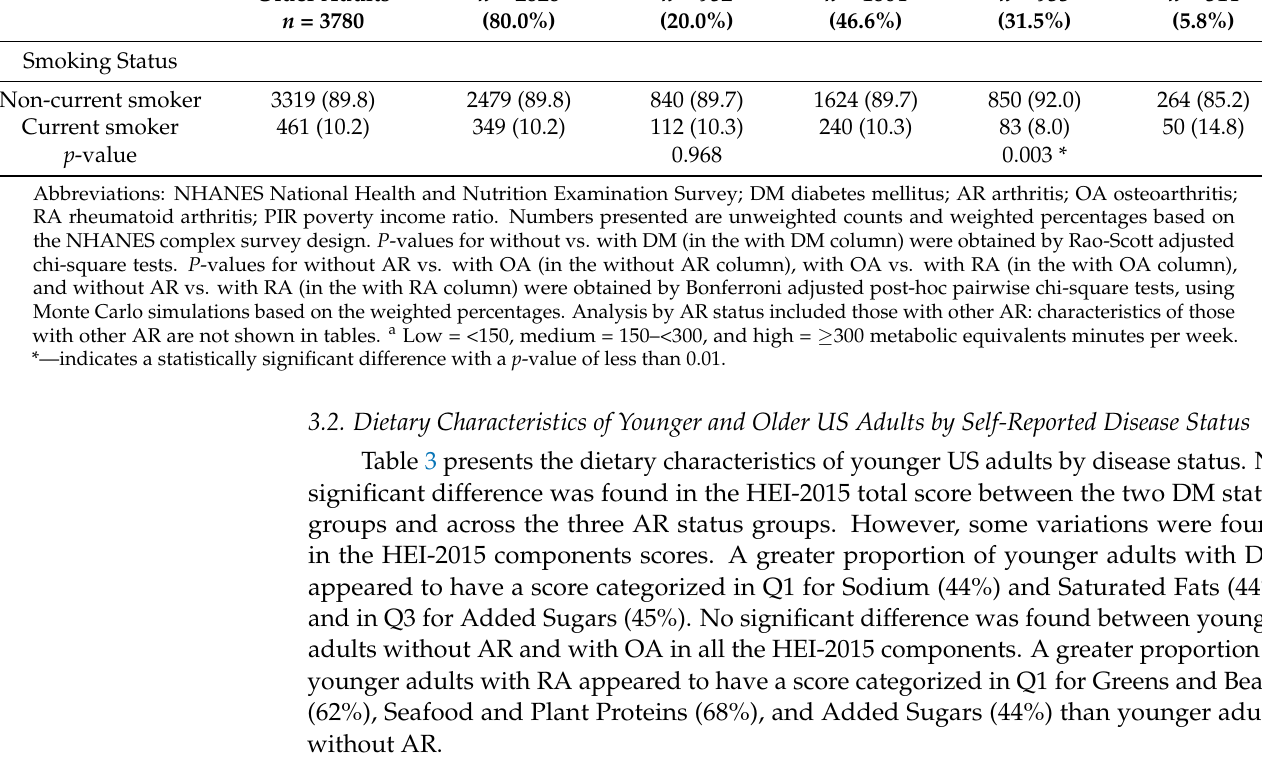
Table 3. Dietary characteristics of younger US adults by self-reported diabetes mellitus status and arthritis status: NHANES